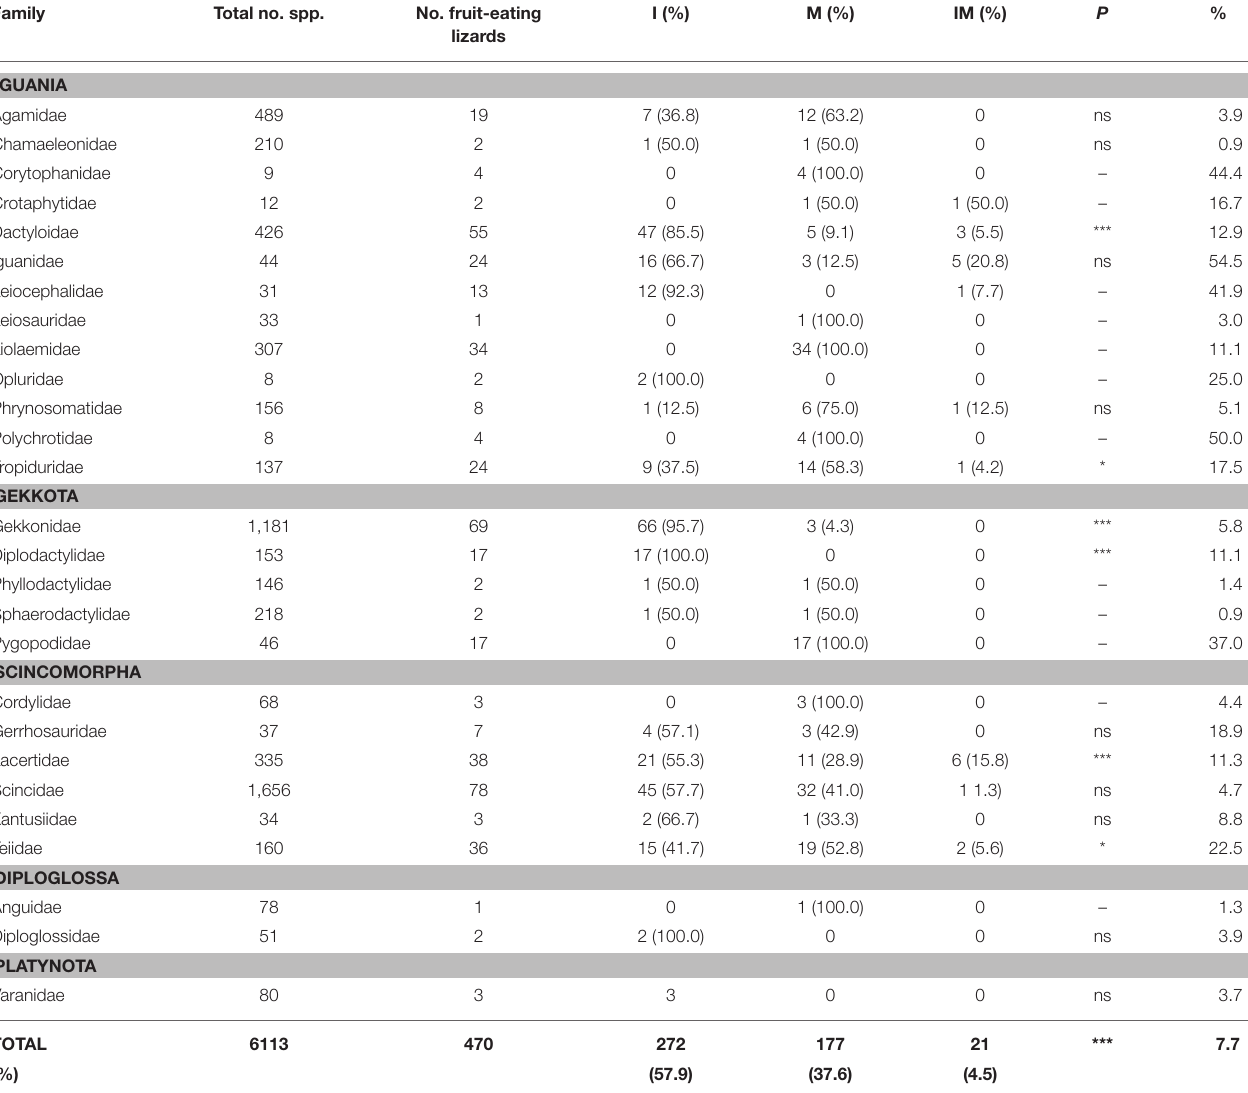
TABLE 2 | Taxonomic and geographical distribution of fruit-eating lizard families. Family Total no.